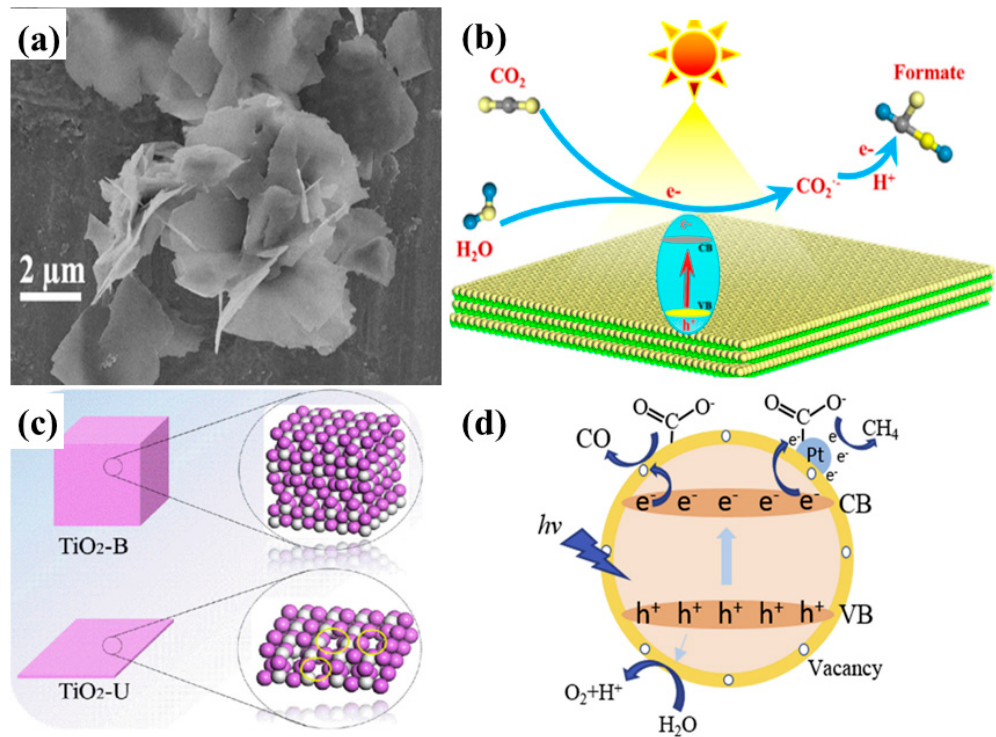
Figure 9. ( a ) SEM image of the TiO 2 -Octylamine hybrid nanostructure, and ( b ) schematic view